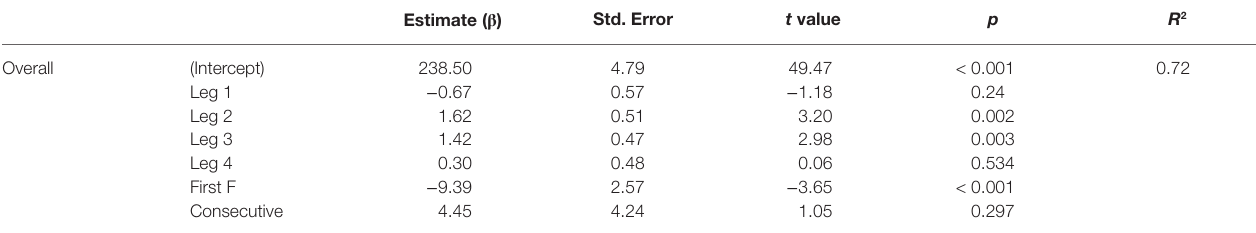
TABLE 1 | Linear regression model for the 4 × 100 m mixed freestyle relay event during 2015, 2017, and 2019 editions of 50 m World Swimming Championships. Estimate ( β ) Std. Error t value p R